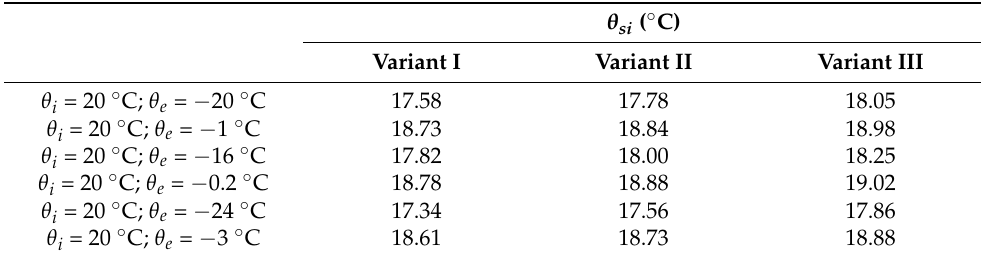
Table 12. In variant I, the thermal transmittance coefficient of this building envelope U = 0.20 W/(m 2 K), in variant II: U = 0.18 W/(m 2 K) and in variant III: U = 0.15 W/(m 2